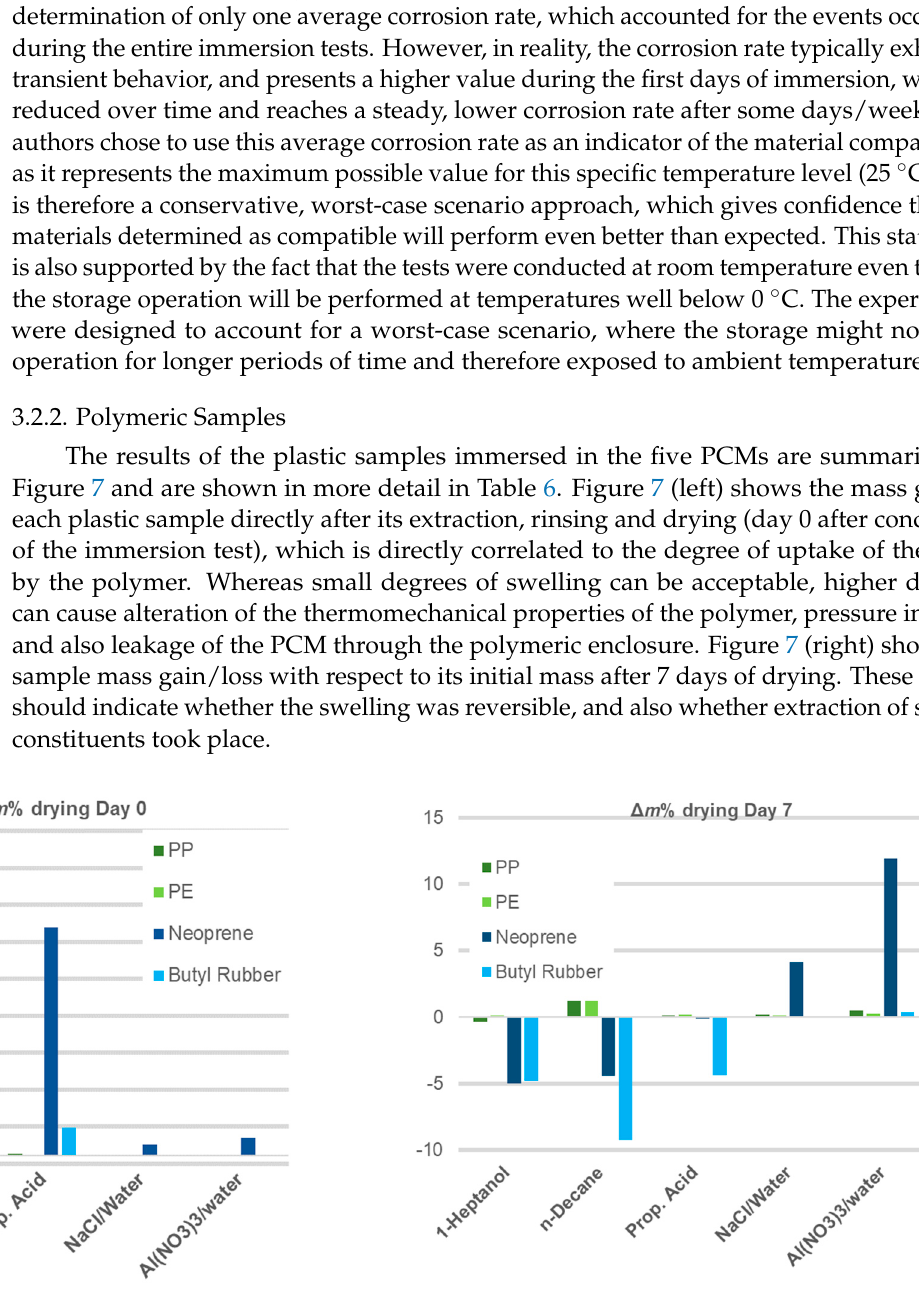
Figure 7. Mass gain% 0 days ( left ) and 7 days ( right ) after extraction from the liquid PCM and drying at room temperature. Note that the two figures have significantly different axis scales.